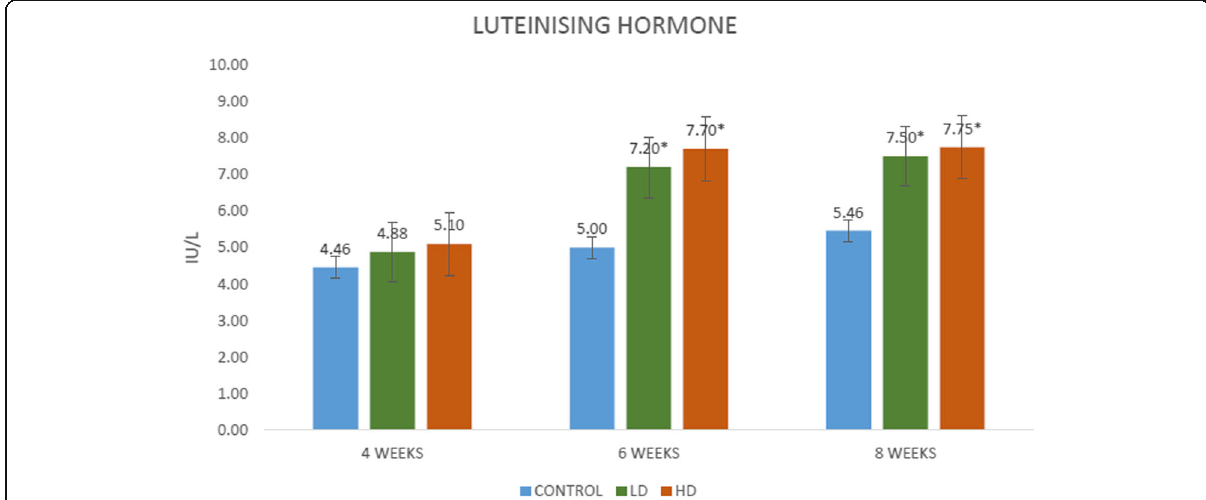
Fig. 4 Effect of administration of aqueous root extract of Chrysophyllum albidum on serum concentration of luteinizing hormone (LH) of the experimental rats at the 4th, 6th and 8th week. Bars represent Mean ± SEM. n = 5. *Superscript shows Mean with significant ( P < 0.05) difference within each